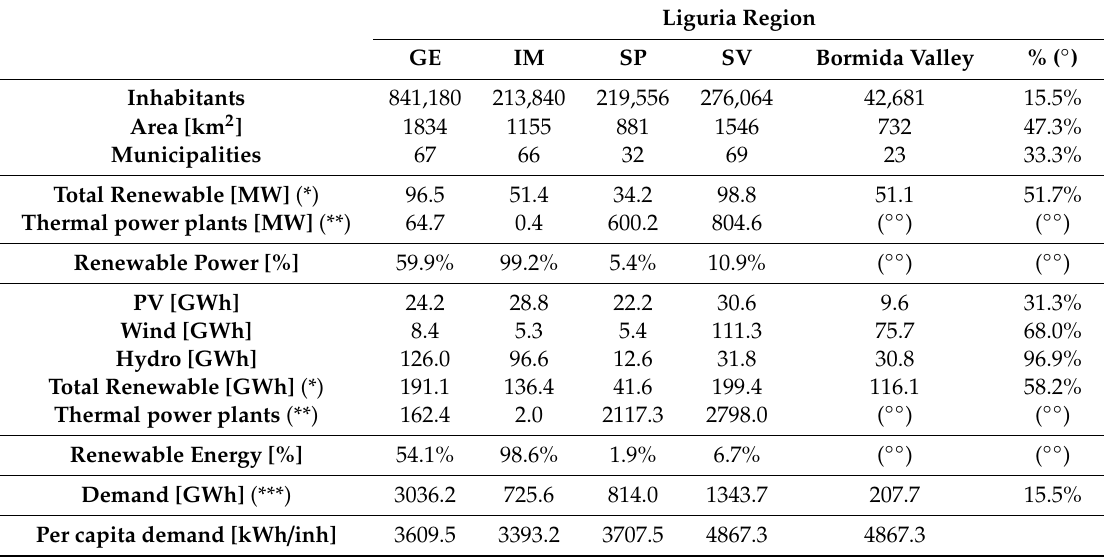
Table 2. Electricity data for the Genoa metropolitan area and for the provinces of Imperia, La Spezia and